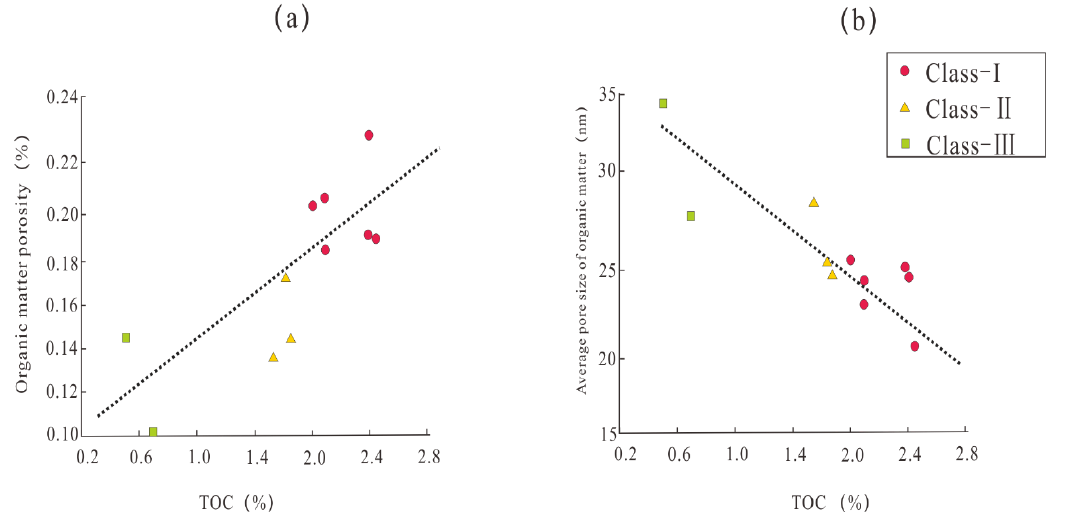
Figure 8. Relationships between TOC and organic matter pore features of shale reservoirs in Da’an area, southern Songliao Basin ( a ) Relationship between TOC and organic matter porosity; ( b ) Relationship between TOC and average size of organic matter pores.